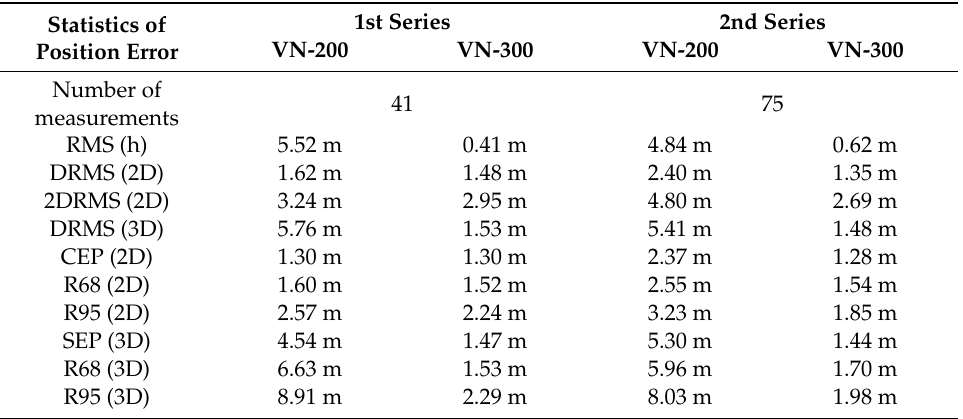
Table 9. Predictable positioning accuracy of VN-200 and VN-300 systems during Inertial Navigation System (INS) measurements in Gda´nsk in section no. 6.